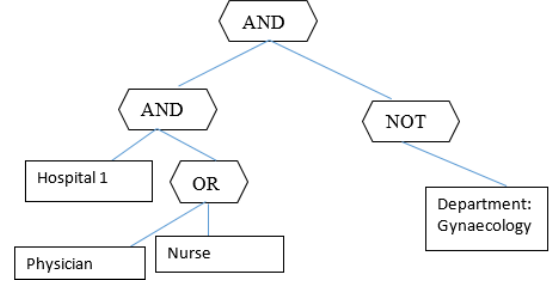
Figure 3. Tree access